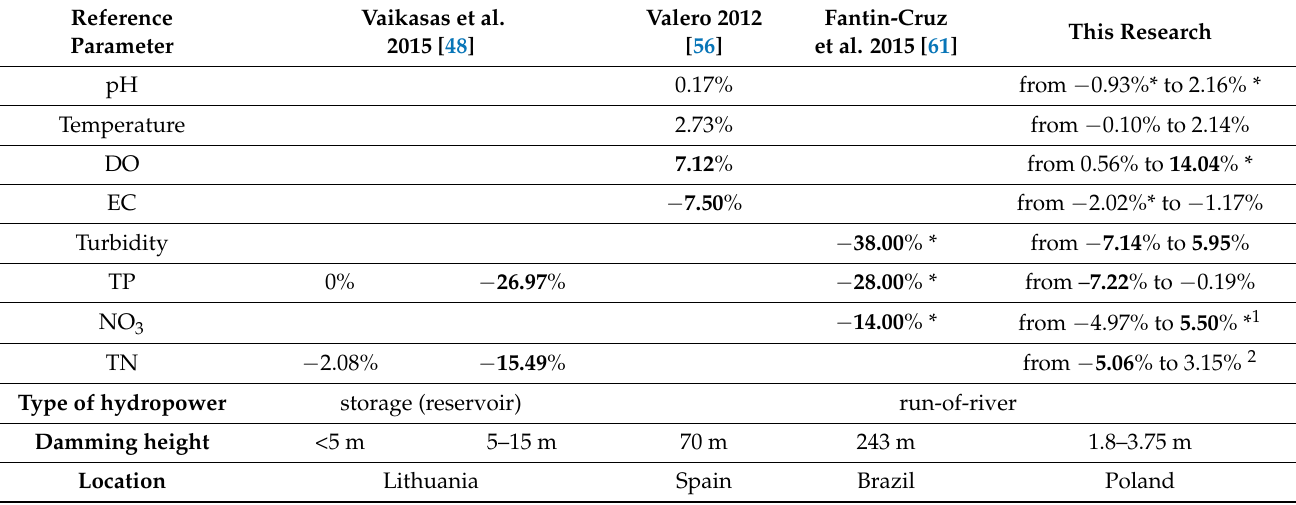
Table 7. Summary of the average percentage changes in the values of physicochemical parameters below selected hy- dropower